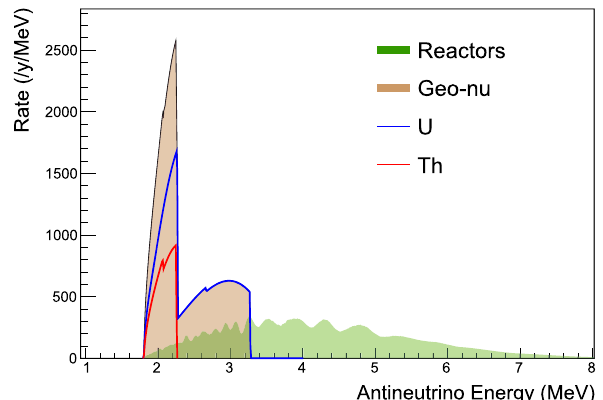
Fig. 16 The detected energy spectrum of the predicted rate of antineu- trinos from nuclear power reactors and Earth, assuming a 50 kT water target, located at